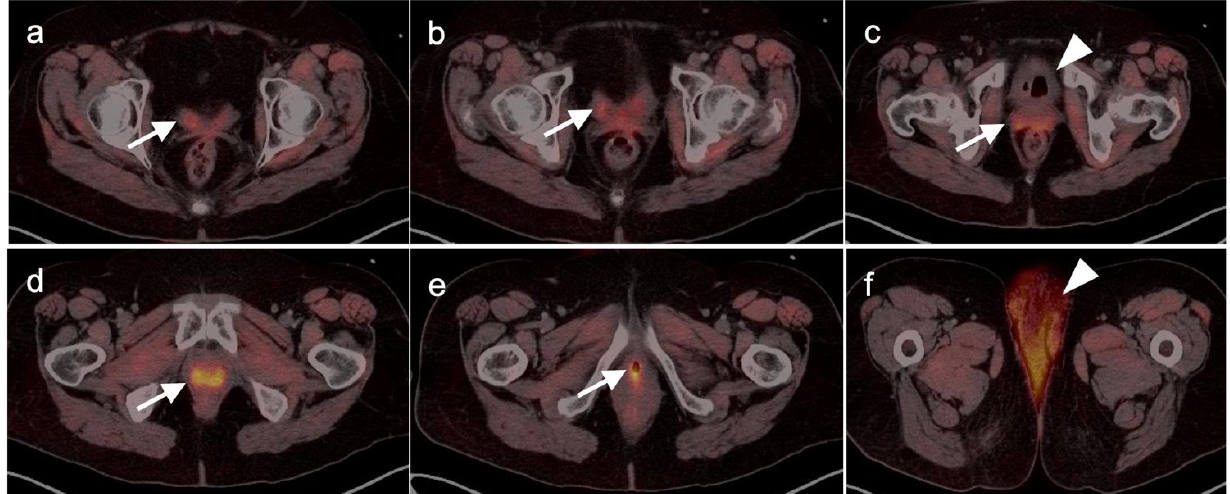
Figure 7. Vesicovaginal fistula on axial FDG PET_CT images of the pelvis. The patient complained of severe incontinence to urine. A vesicovaginal fistula resulted from prior pelvic radiation. Findings on sequential axial FDG PET-CT image of the pelvis include: ( a – e ) The vagina is diffusely filled with radioactive urine (white arrows); ( c ) The urinary bladder is empty and contains air (white arrowhead); ( f ) Radioactive urine is soaking the sanitary pad (white arrowhead).